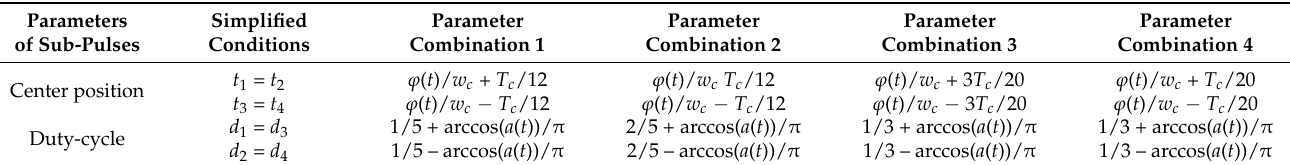
Table 1. Parameter Groups of Three-Level Pulses When ∆ t 1 = ∆ t 2